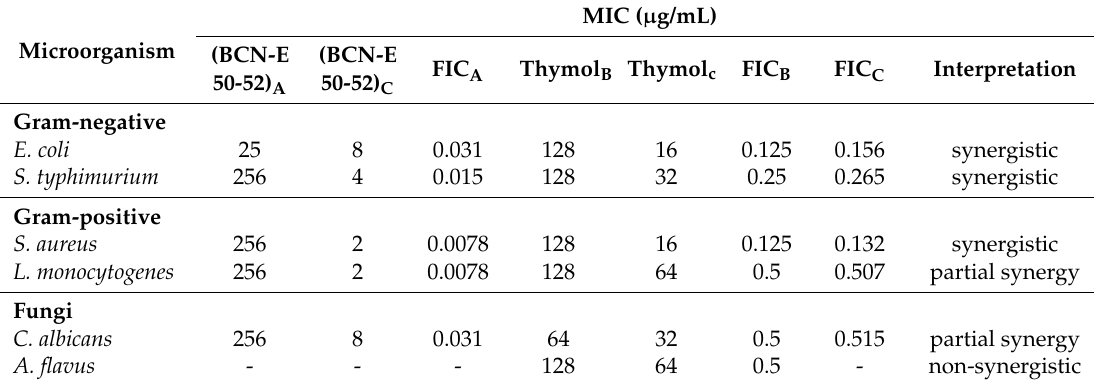
Table 1. The minimum inhibitory concentrations (MICs) of BCN-E 50-52, thymol, and their combinations against different microorganisms.